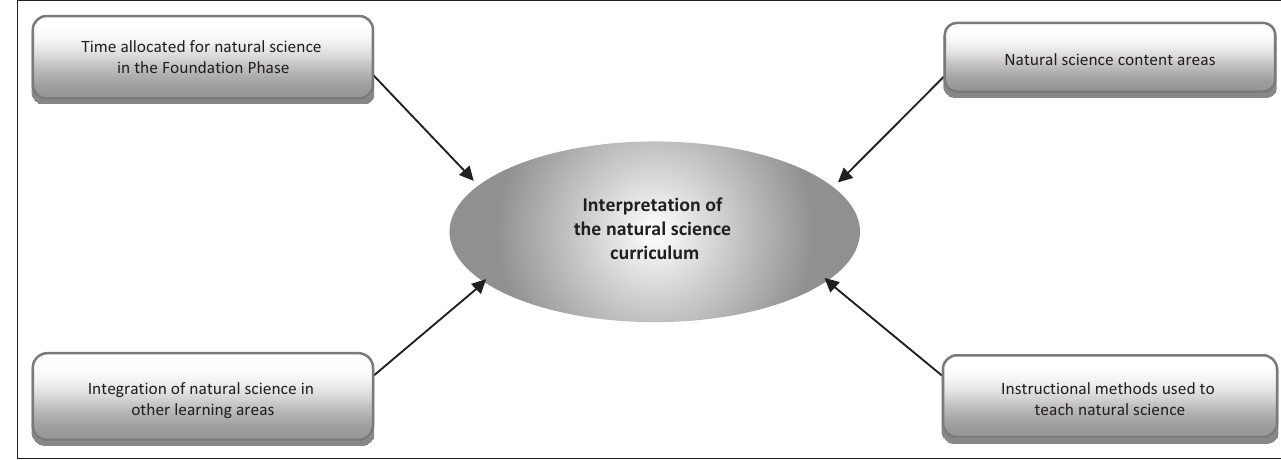
FIGURE 1: Factors that influence teachers’ interpretation of the natural science